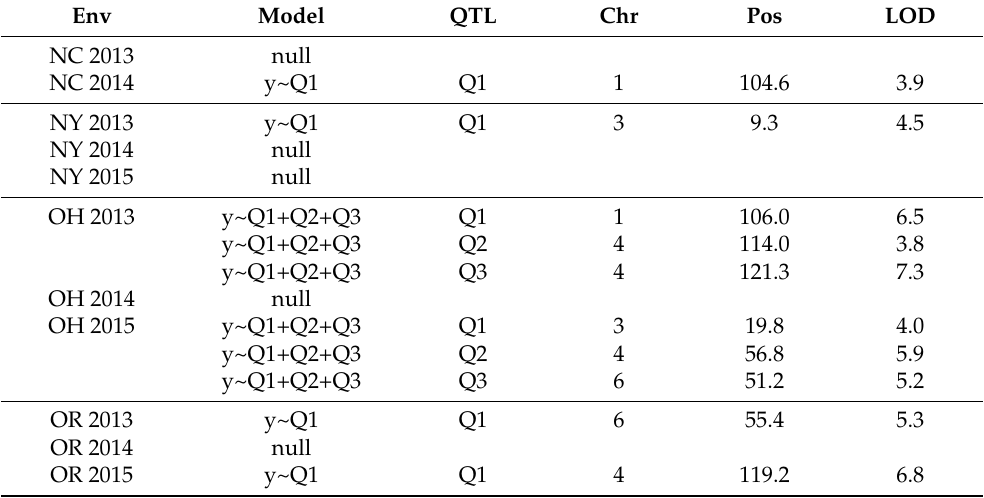
Table 6. Titratable acidity QTL identified by single-environment analysis. Single-environment analy- sis was performed using the R software ‘qtl’ package. Best-fit additive models were selected via for- ward/backward selection. Penalty values were calculated from 1000 permutations of a two-dimensional, two-QTL scan ( p ≤ 0.1). Env